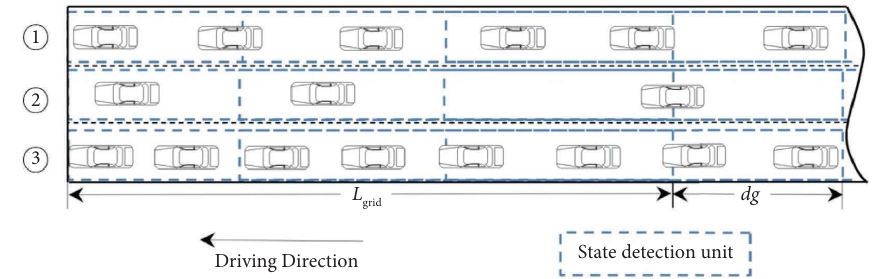
Figure 1: Illustration of the state detection